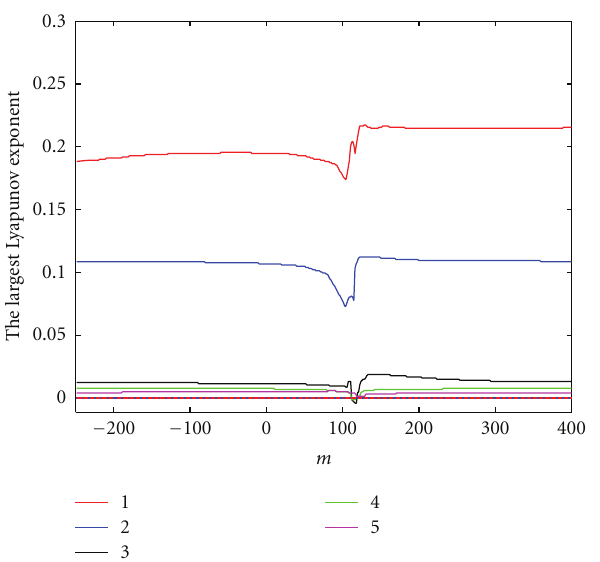
Figure 5: The relationship of the largest Lyapunov exponents (LLEs) and m under di ff erent coupling parameter values. Curve 1 is with k = − 10 . Curve 2 is with k = − 50 . Curve 3 is with k = − 70 . Curve 4 is with k = − 100 . Curve 5 is with k = − 150 .